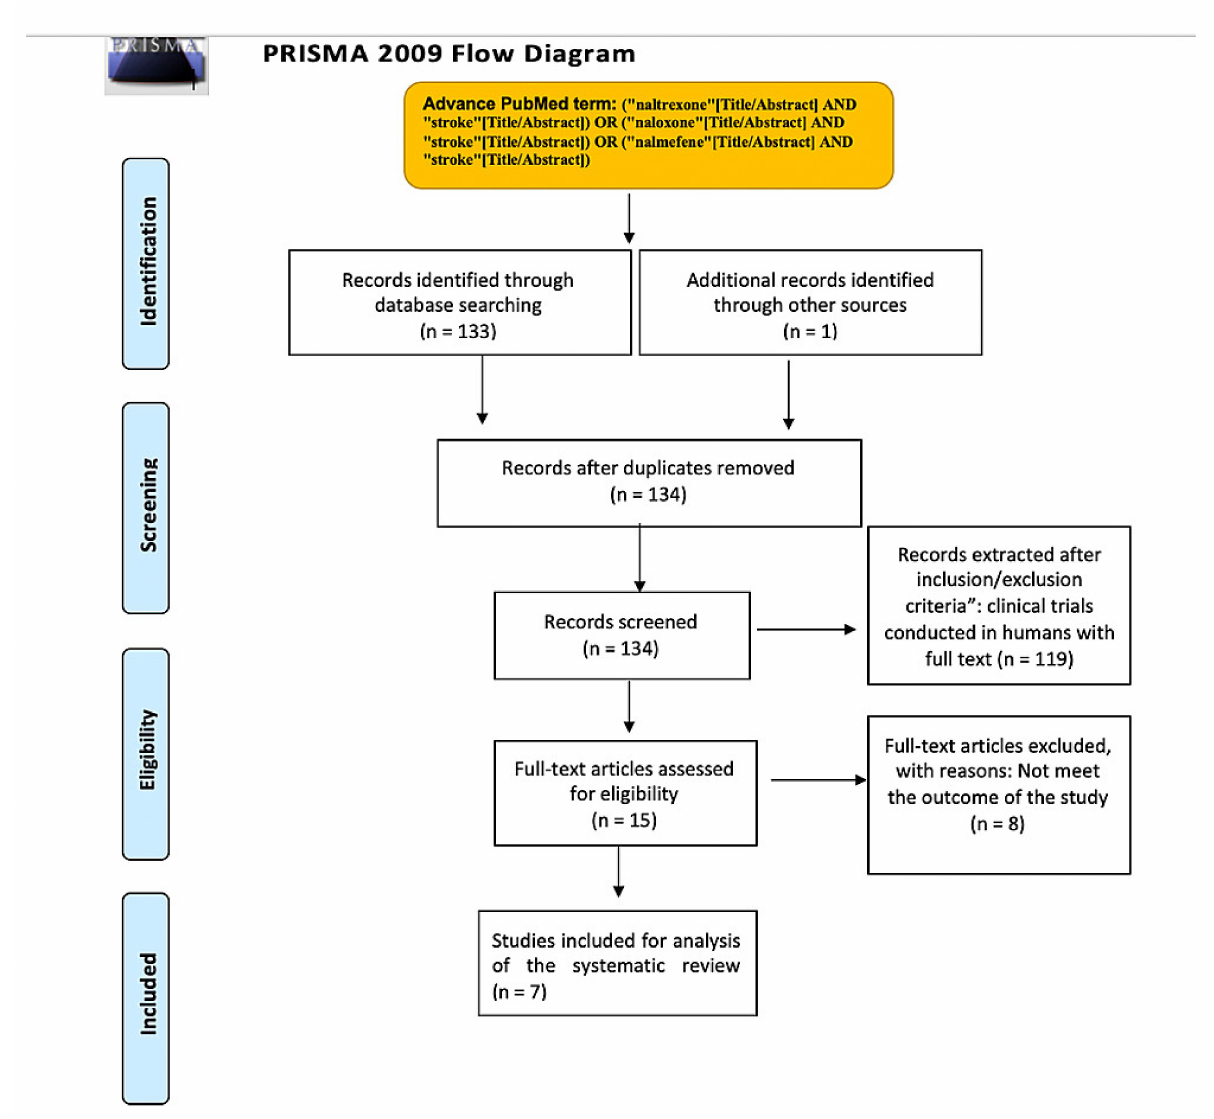
Figure 1. PRISMA Flowchart of the systematic